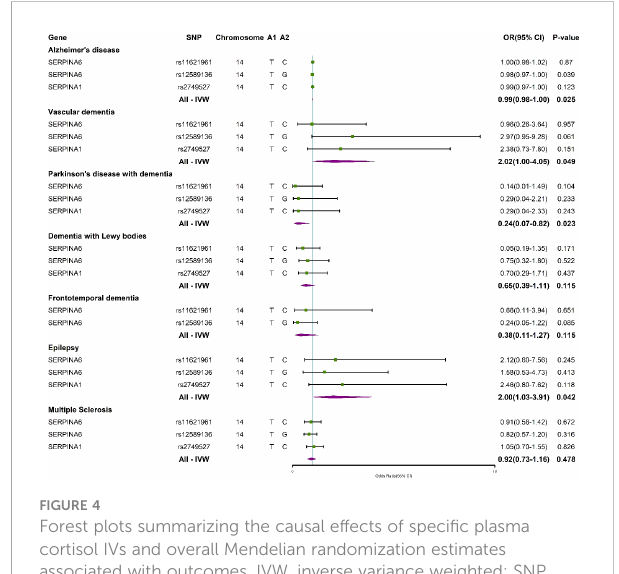
FIGURE 4 Forest plots summarizing the causal effects of speci fi c plasma cortisol IVs and overall Mendelian randomization estimates associated with outcomes. IVW, inverse variance weighted; SNP, single nucleotide polymorphism; OR, odds ratio; CI, con fi dence